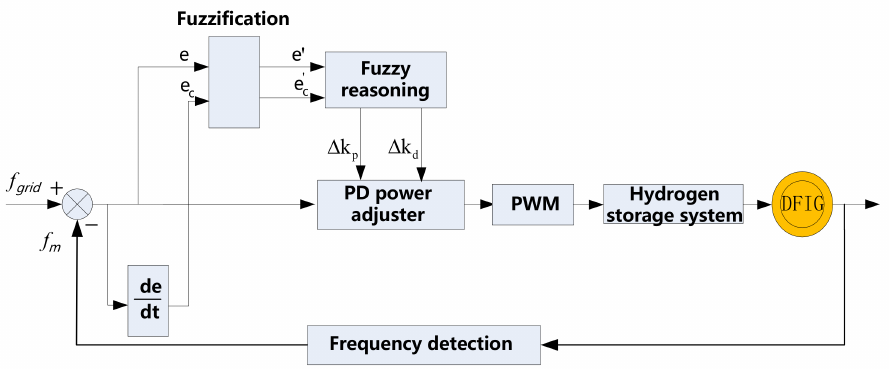
Figure 3. Fuzzy adaptive PD control structural drawing.